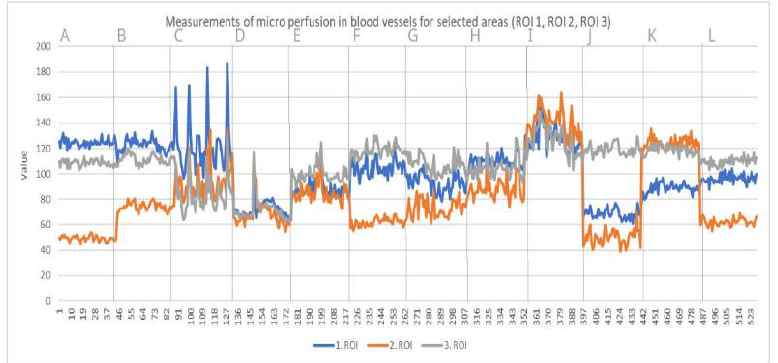
Figure 8. Measurements of microperfusion in blood vessels in selected areas—Case 2. Legend: ROI—Region of Interest.